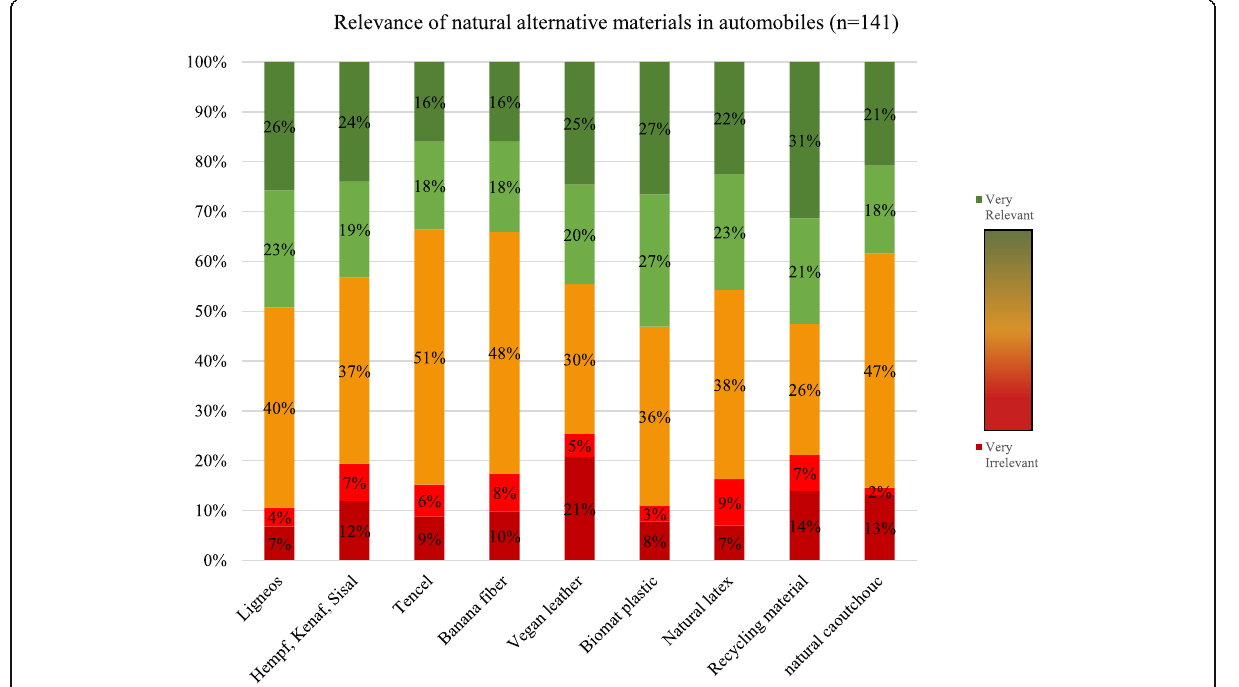
Fig. 7 Relevance of natural alternative materials in automobiles. Source: Own illustration